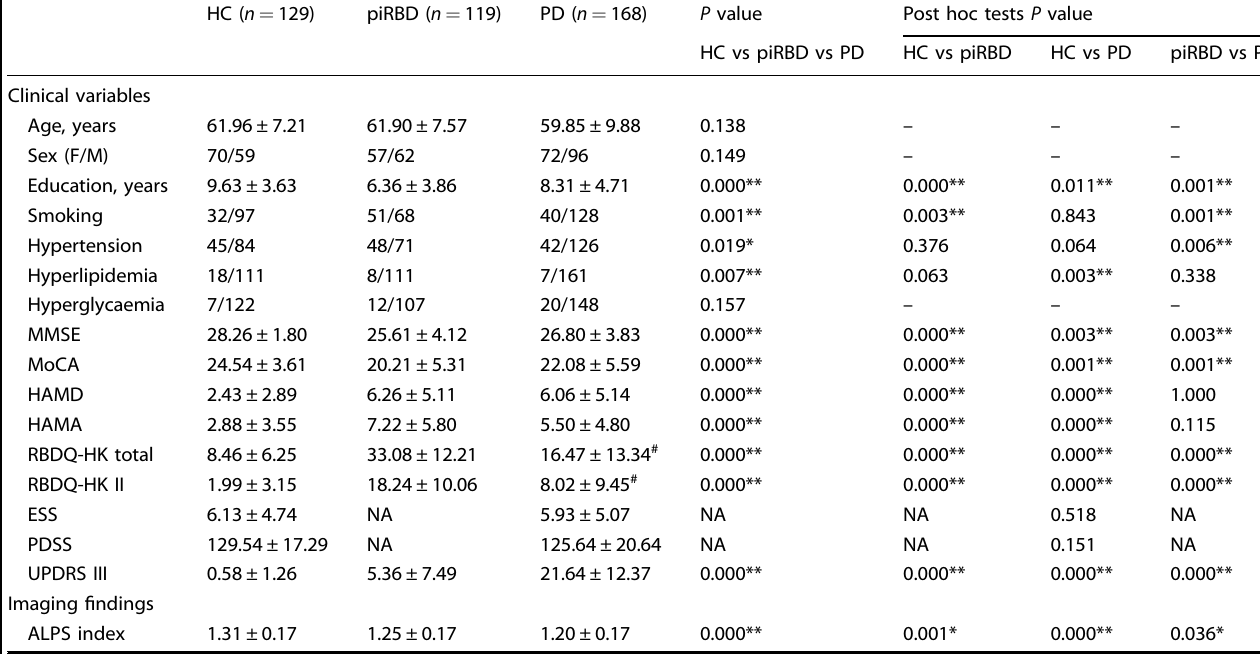
Table 1. Baseline characteristics and Imaging fi ndings of the three participant